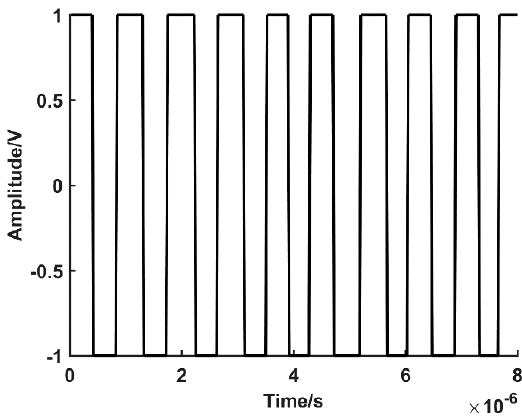
Figure 8. Arc tangent results of two channels signal.